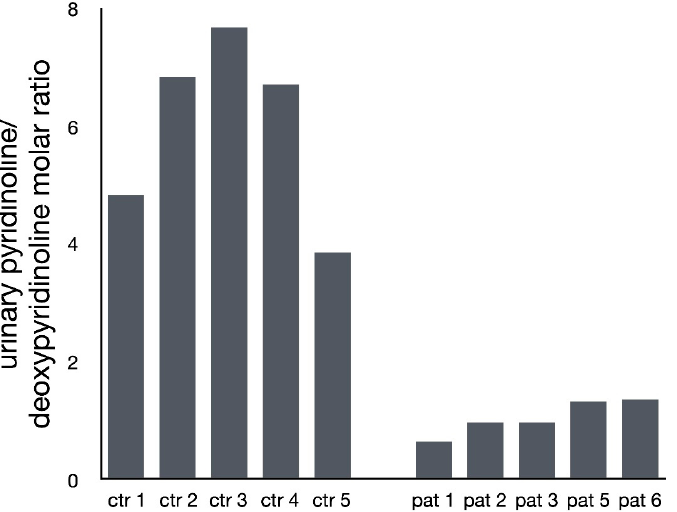
Figure 3. Ratio of the collagen crosslink derivates, pyridinoline and deoxypyridinoline, in the urine of five SLC39A3-dificient individuals and in five roughly age-matched controls. The ratio is consistently lower in SLC39A13-deficient individuals, with no overlap to the control group.